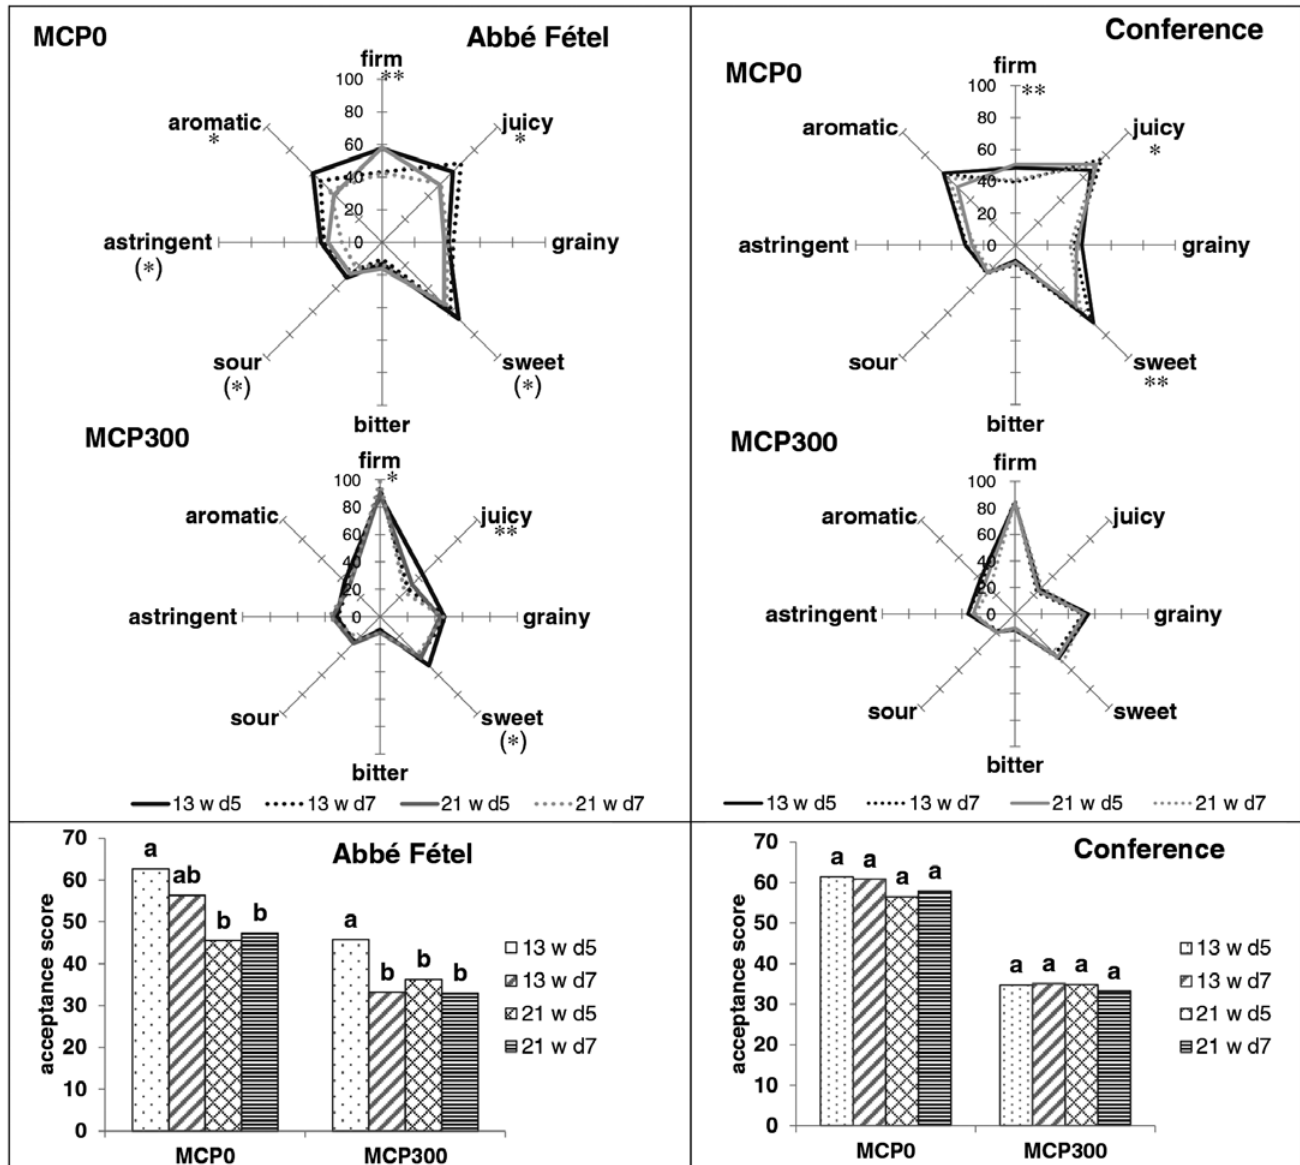
Fig. 6 - Sensory profiles and overall acceptability of control (MCP0) and 1-MCP treated (MCP300) ‘Abbé Fétel’ and ‘Conference’ pears after 13 and 21 weeks of storage and 5 (d5) and 7 (d7) days of shelf life at 20°C. Within each 1-MCP dose, for each attribute the significance of F- ratio (**, P<0.01; *, P<0.05; (*), P<0.10; no symbol, not significant) is reported. Within each 1-MCP dose, bars with different letters refer to statistically different means (Tukey’s test, P <